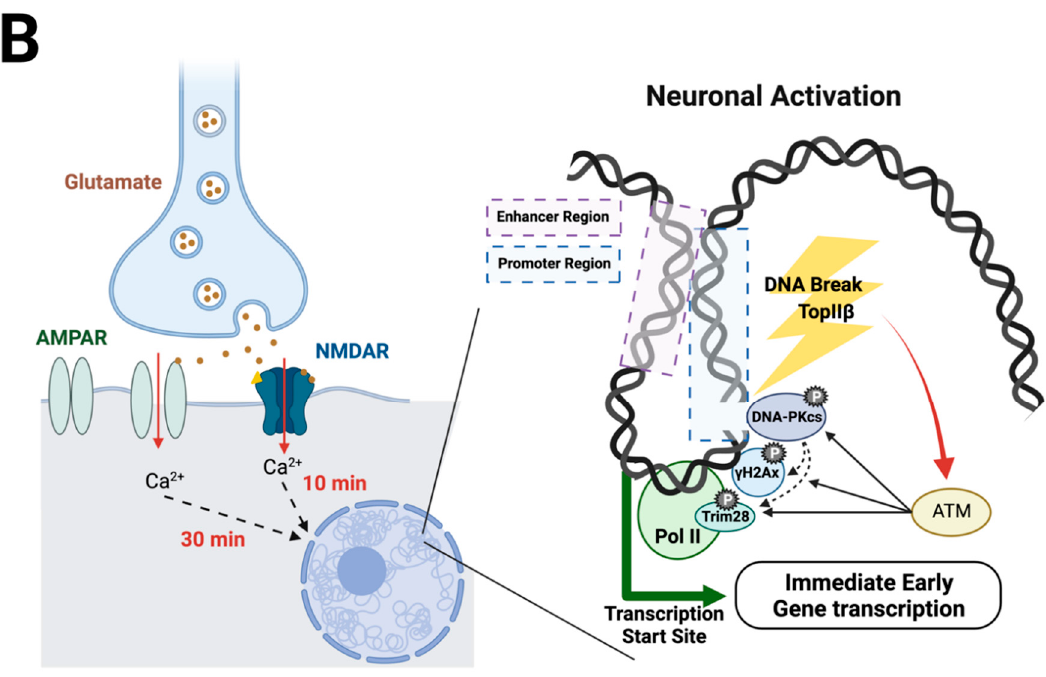
Figure 1. Suggested mechanims of adaptive DSBs. ( A ) At baseline, transcription is held in pause. Trim28 holds RNA polymerase II (Pol II) in pause, and topological factors prevent the enhancer and promoter regions from interacting. ( B ) Neuronal activation occurs with the binding of glutamate to NMDARs and AMPARs, allowing an influx of calcium that initiates a signal cascade into the nucleus. Following this cascade, topoisomerase II β initiates a DSB downstream of the transcription start site. The DSB activates ATM, which induces phosphorylation of DNA-PKcs, Trim28, and H2Ax. Trim28 phosphorylation releases Pol II, which then becomes active to induce transcription of IEGs. Additionally, the DSB releases topological constraints, allowing the enhancer and promoter regions to